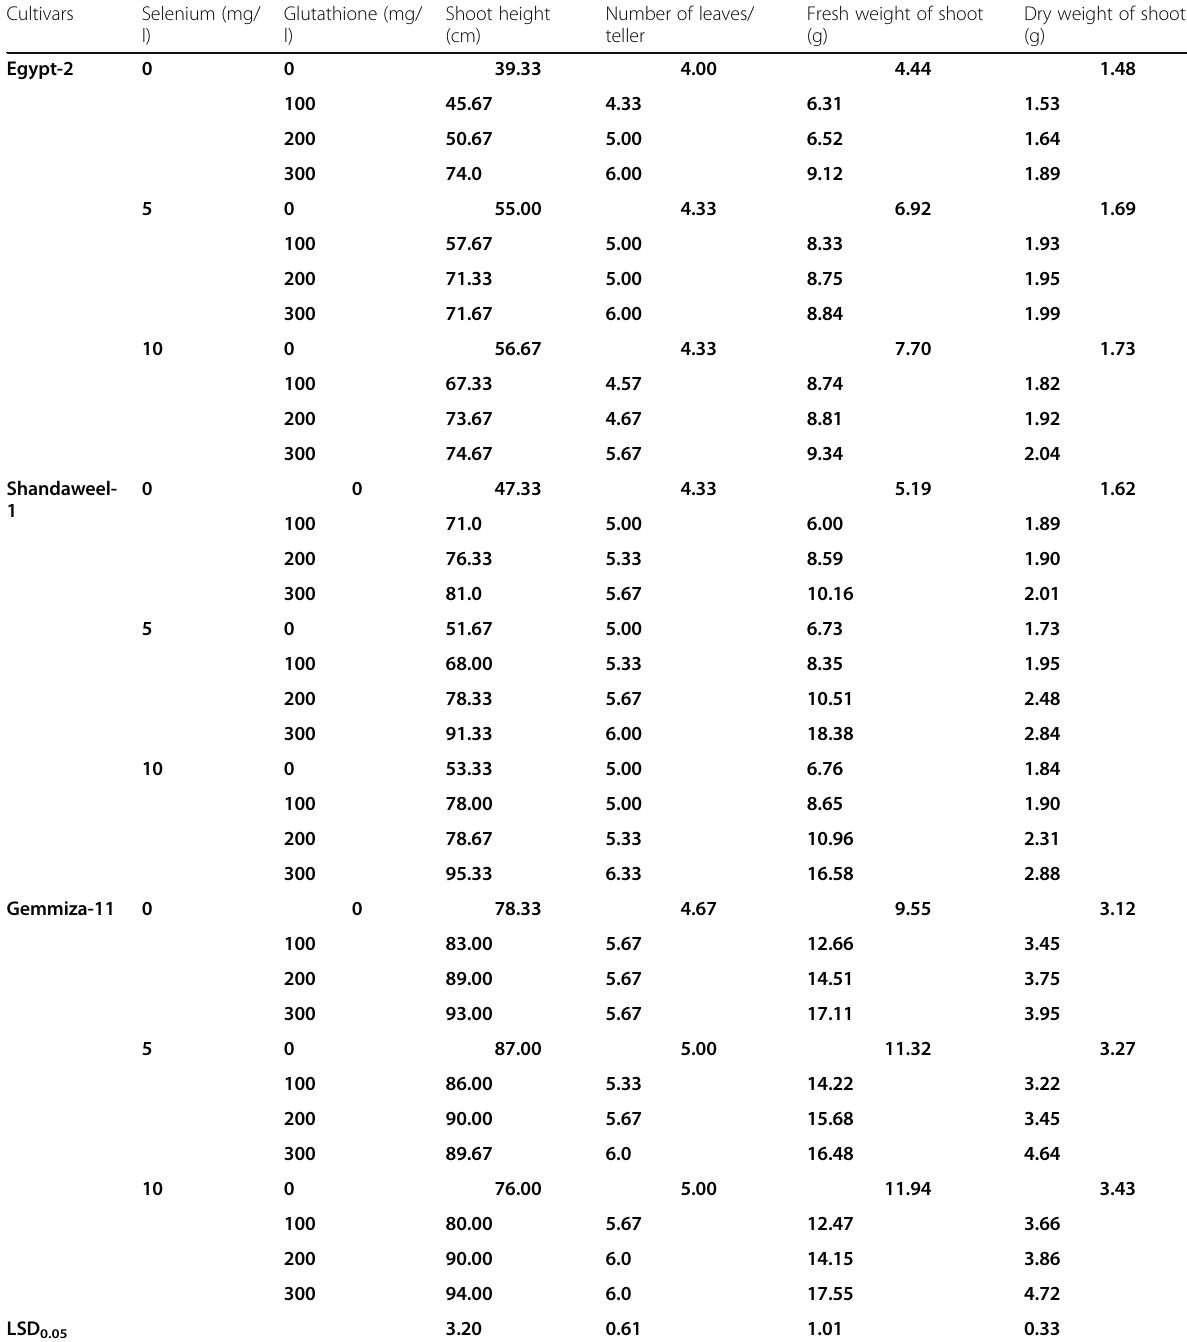
Table 1 Effect of glutathione and/or selenium on vegetative growth parameters of three wheat cultivars grown under conditions of the Nubaria region Cultivars Selenium (mg/ l)